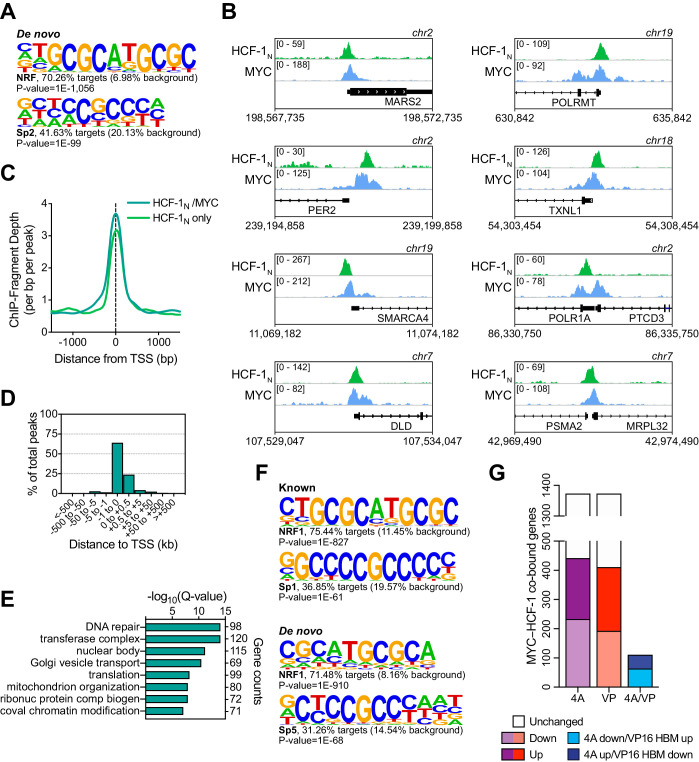
Comparison of MYC and host cell factor (HCF)–1N localization on Ramos cell chromatin.(A) De novo motif analysis of HCF-1N peaks in Ramos cells. Two of the most highly enriched motifs are shown, as well as the percentage of target and background sequences with the motif, and the p-value. (B) Example IGV screenshots of regions that have overlapping MYC and HCF-1N in Ramos cells. (C) Normalized HCF-1N ChIP-Seq fragment counts where peaks overlap with MYC (HCF-1N/MYC) compared to where they do not overlap (HCF-1N only). Data are smoothed with a cubic spline transformation. (D) Distribution of regions that overlap between MYC and HCF-1N peaks in Ramos cells in relation to the nearest TSS. (E) Gene ontology enrichment analysis of genes nearest to regions of overlap between MYC and HCF-1N peaks. (F) Known and de novo motif analysis of regions that overlap between MYC and HCF-1N peaks in Ramos cells. For each motif represented, percentage of target and background sequences with the motif and p-value are shown. (G) Relationship between protein-coding genes that are co-bound by promoter-proximal MYC and HCF-1N by ChIP-Seq, and are significantly (false discovery rate [FDR] < 0.05) decreased or increased in response to the 4A or VP16 HCF-1-binding motif (HBM) mutations. Also shown are genes where the expression changes were anti-correlated between the 4A and VP16 HBM mutants.